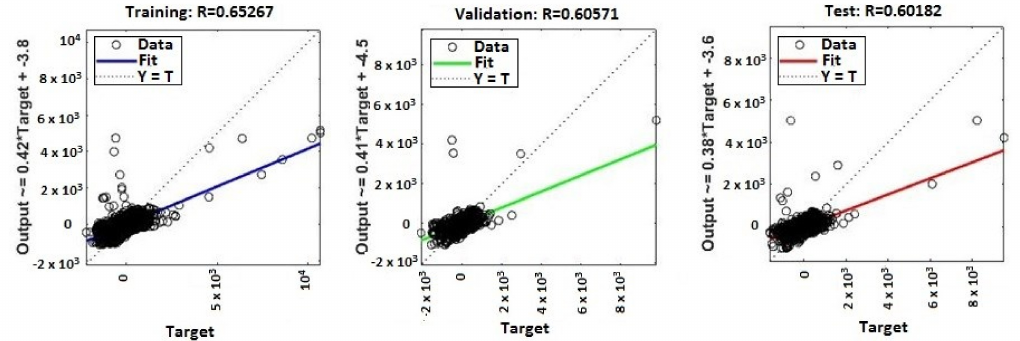
Figure 10. Regression ( R 2 ) for validation, test, and training—ANN with 50 neurons.